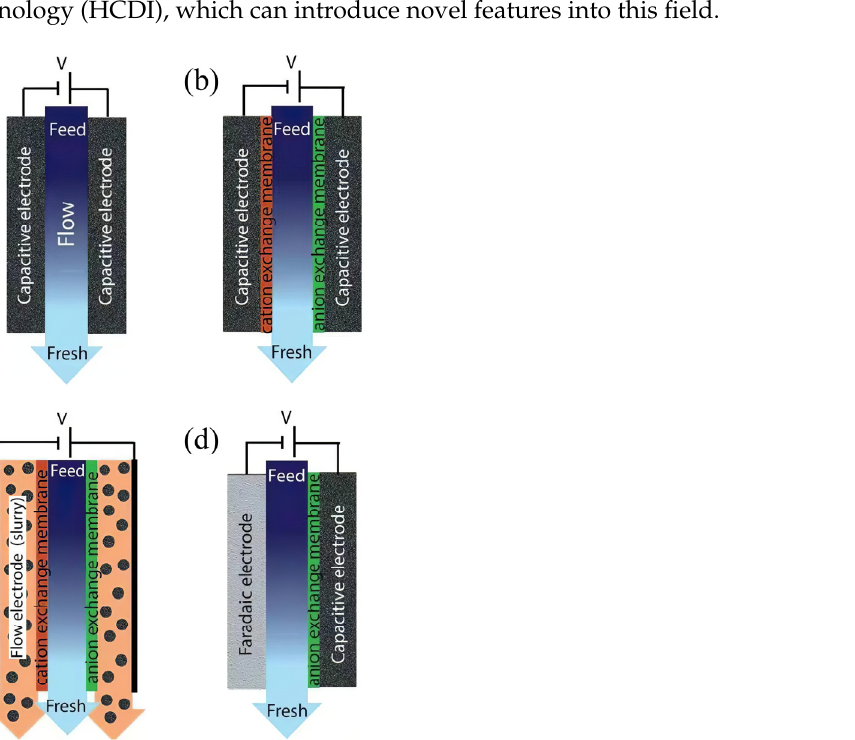
Figure 2. Schematic diagrams of ( a ) traditional CDI cell, ( b ) MCDI cell, ( c ) FCDI cell, ( d ) HCDI cell. Reprinted from Reference [33] with permission.